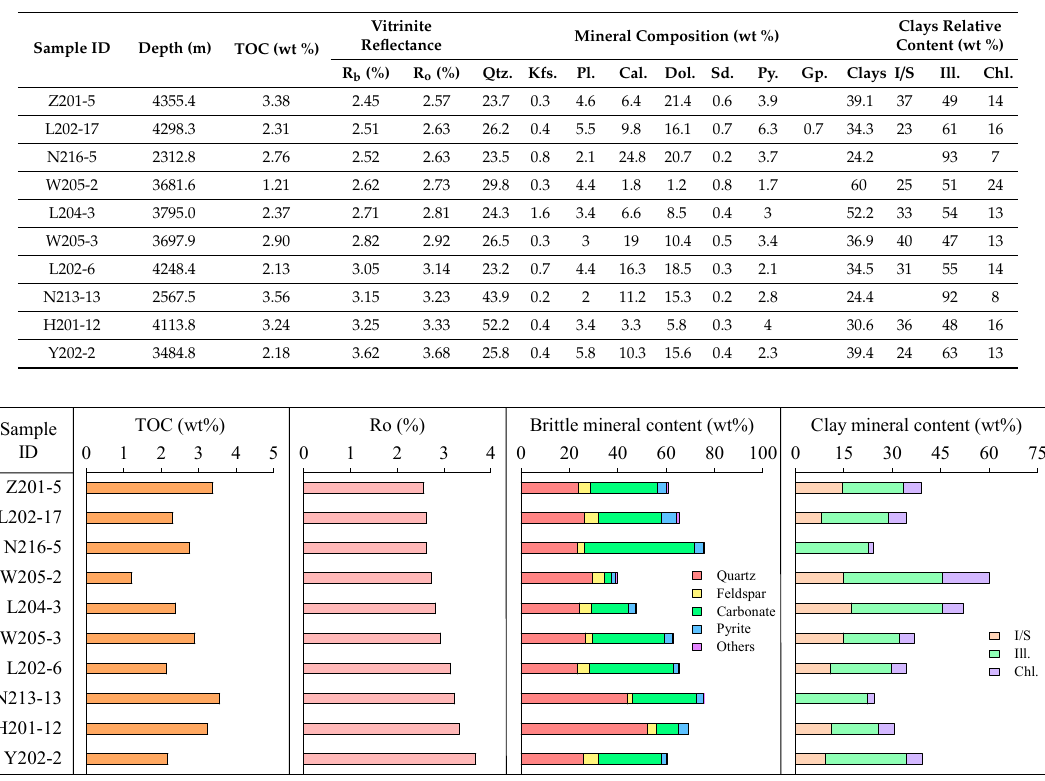
Figure 2. TOC content, thermal maturity and mineral composition of Longmaxi shale.